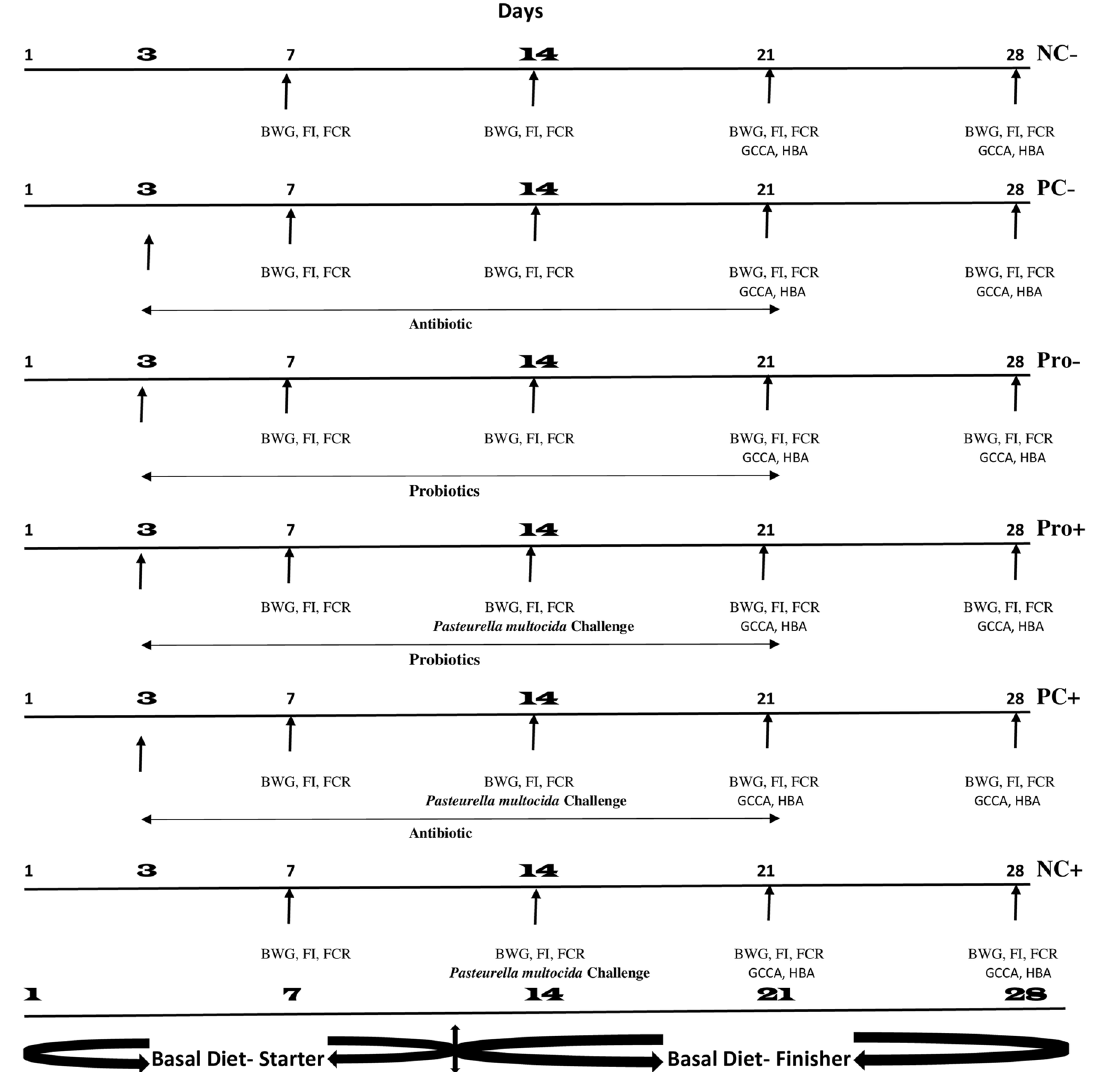
Figure 2. Schematic illustration of the experimental design. Birds were fed basal diet all through the experiment. Treatment groups included: NC−: unchallenged negative control; PC−: unchallenged positive control; Pro−: unchallenged probiotics control; Pro+: challenged probiotic control; PC+: challenged positive control; NC+: challenged negative control. BWG body weight gain, FCR feed conversion ratio, FI feed intake, GCCA gut content and carcass analysis, HBA haemato-biochemical